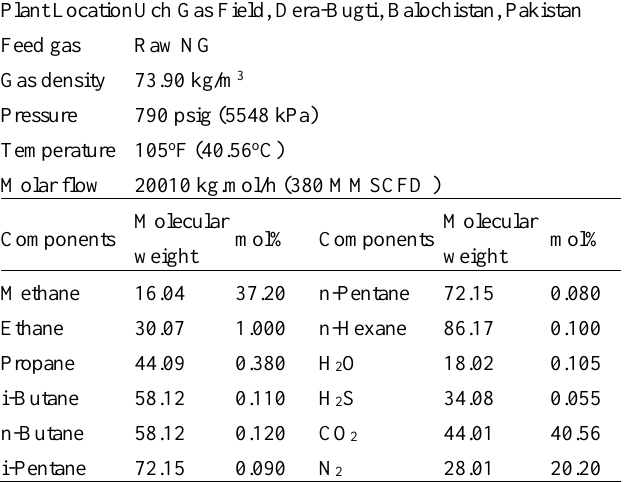
Operating conditions and composition of feed gas